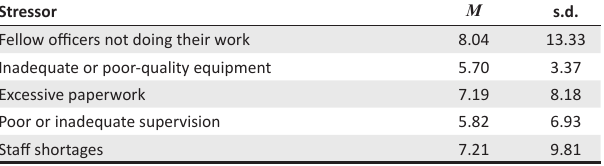
TABLE 5: The most frequently occurring stressors in previous 6 months. Stressor M